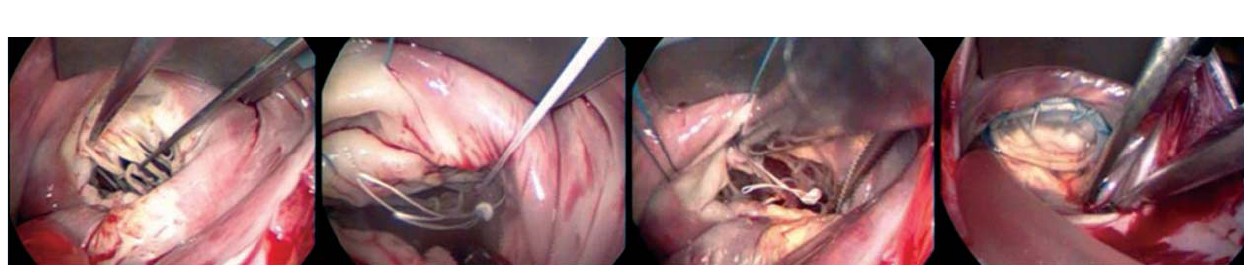
Fig. 3 - Identificação da ruptura de cordas para cúspide anterior da valva mitral, implante de loops de Gore-Tex®, sua fixação no músculo papilar e cúspide anterior e aspecto final da plastia